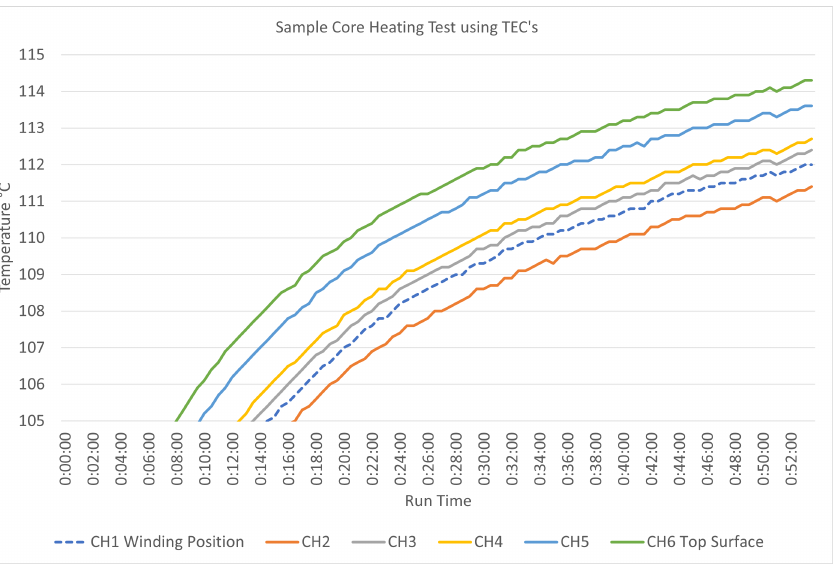
Figure 14. Temperature results of the core sample at 7 TEC power settings.